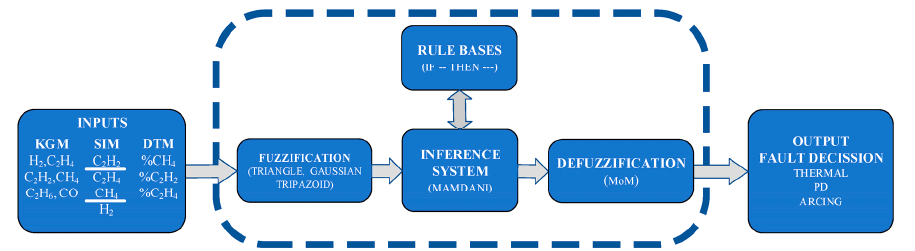
Figure 2. Fuzzy Logic flow chart.